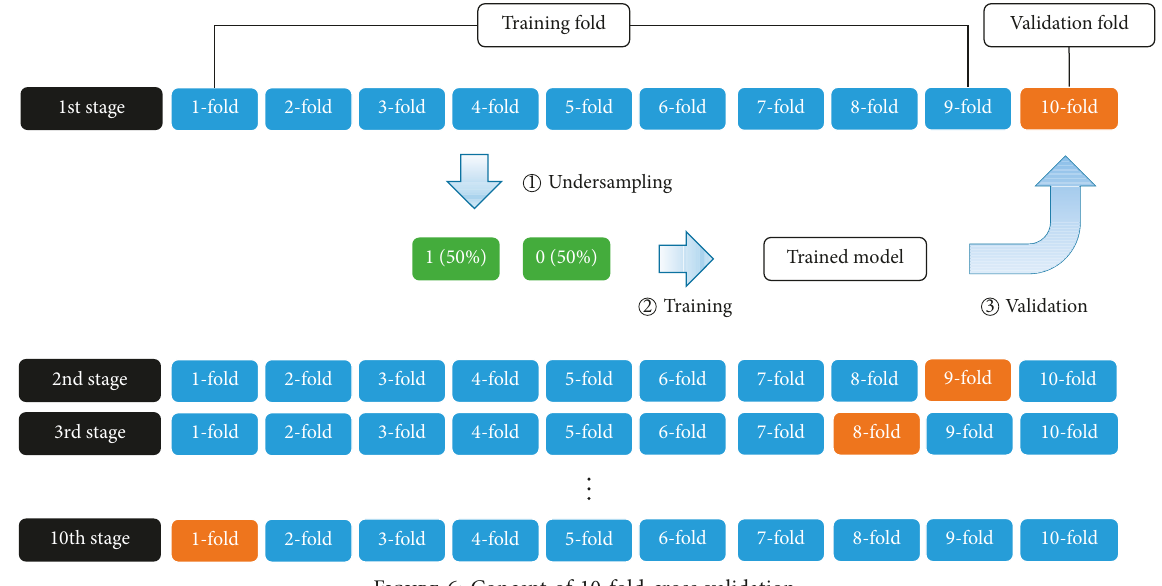
Figure 6: Concept of 10-fold cross validation.